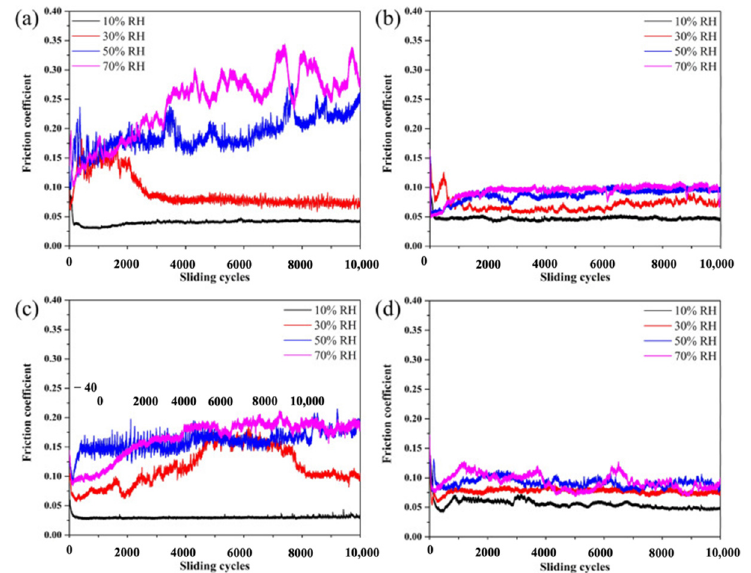
Figure 8. Tribological testing in the air at different RH and corresponding variation in CoF for ( a ) MoS 2 , ( b ) MoS 2 –Ti, ( c ) MoS 2 –Pb, and ( d ) MoS 2 –Pb–Ti films. Reproduced with permission [27]. Copyright, 2018.